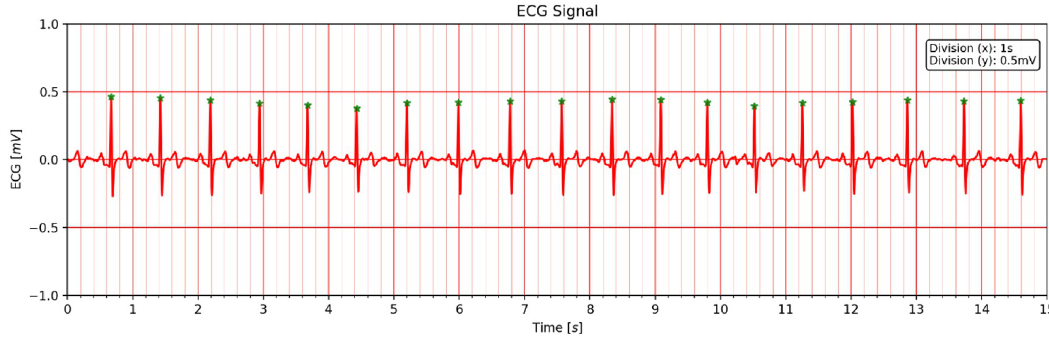
Fig 4. ECG signal after median